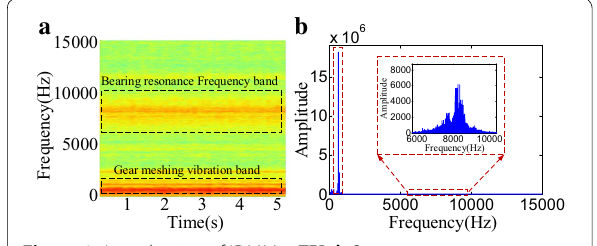
Figure 3 Introduction of IDMM: a TFR; b